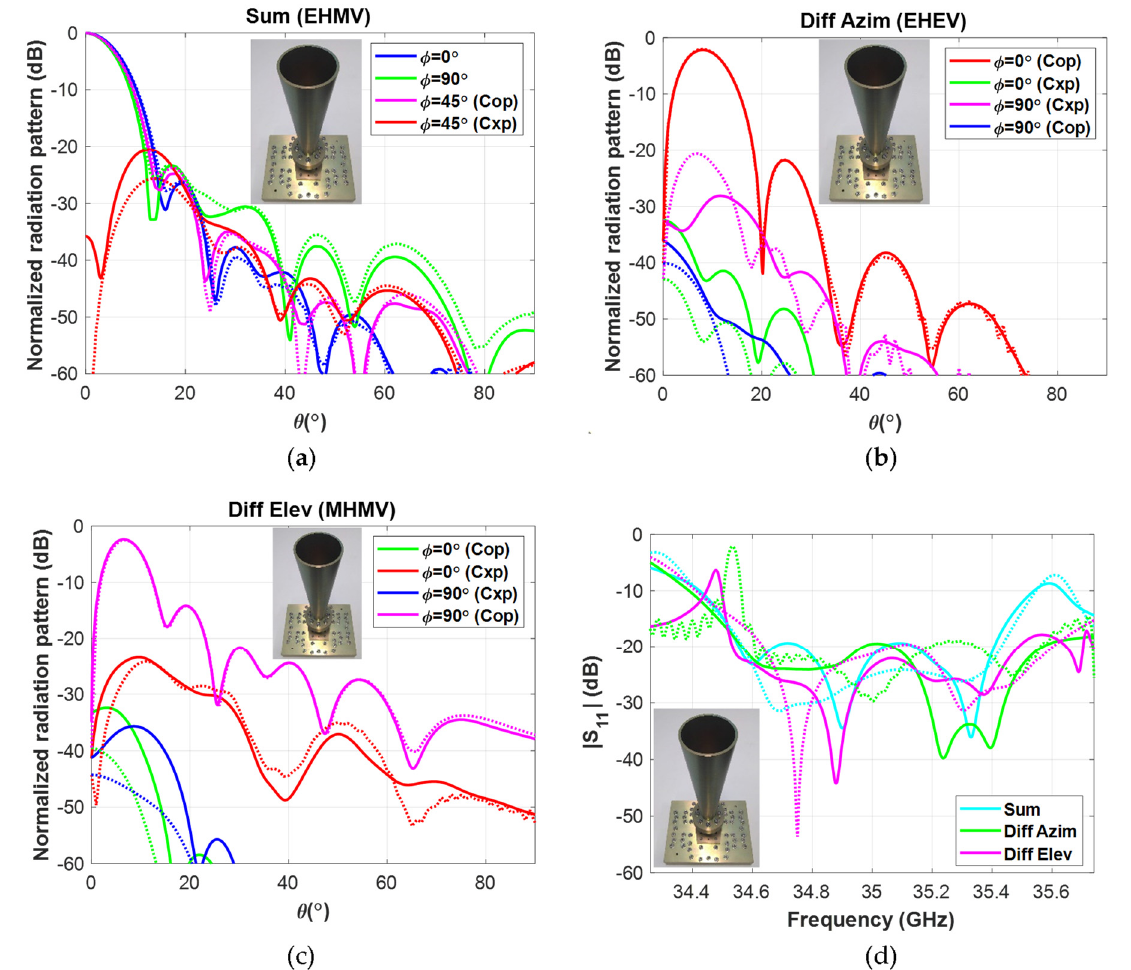
Figure 4. Measured (solid) and simulated (dotted) performances of the triple-radiation pattern monopulse horn antenna: ( a ) sum radiation pattern, D irectivity , Meas = 24.85 dBi ; ( b ) difference in azimuth radiation pattern, D irectivity , Meas = 22.66 dBi ; ( c ) difference in elevation radiation pattern, D irectivity , Meas = 22.44 dB ; and ( d ) reflection coefficient for each radiation pattern. Table 1. Comparison of triple-radiation pattern monopulse antennas by high-precision subtractive machining.